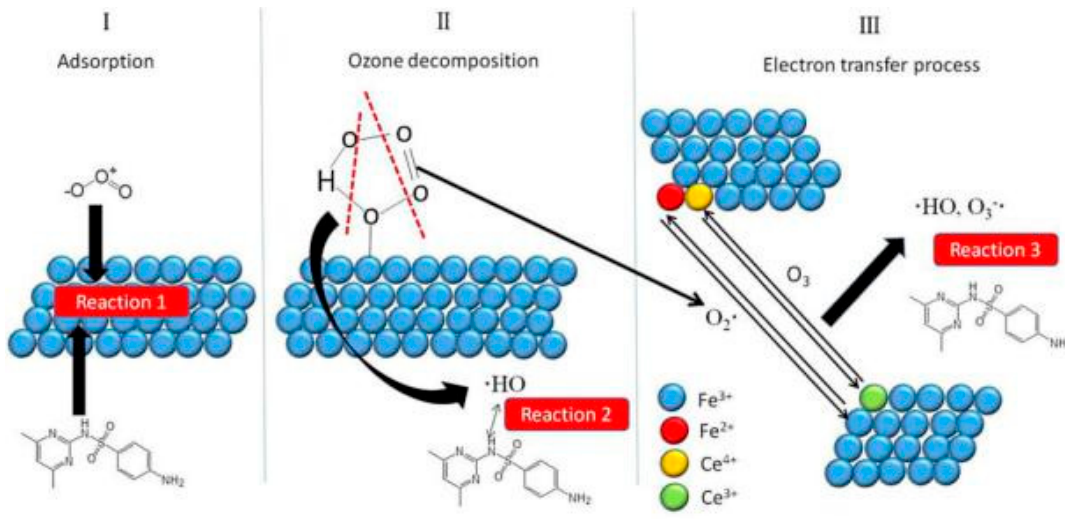
Figure 9. Schematic of possible catalytic mechanisms.